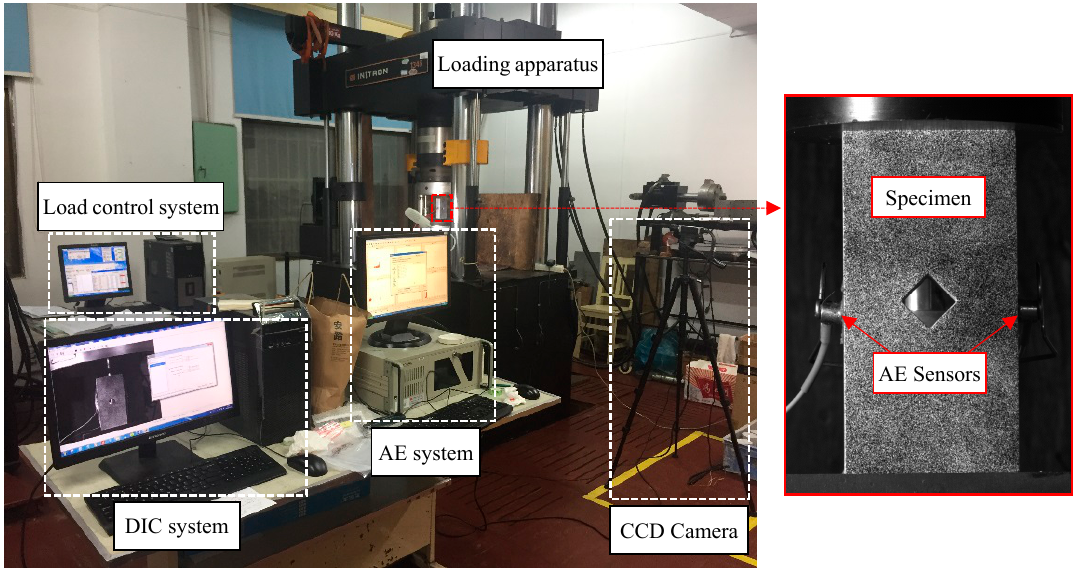
Figure 2. Photographic view of the testing system.